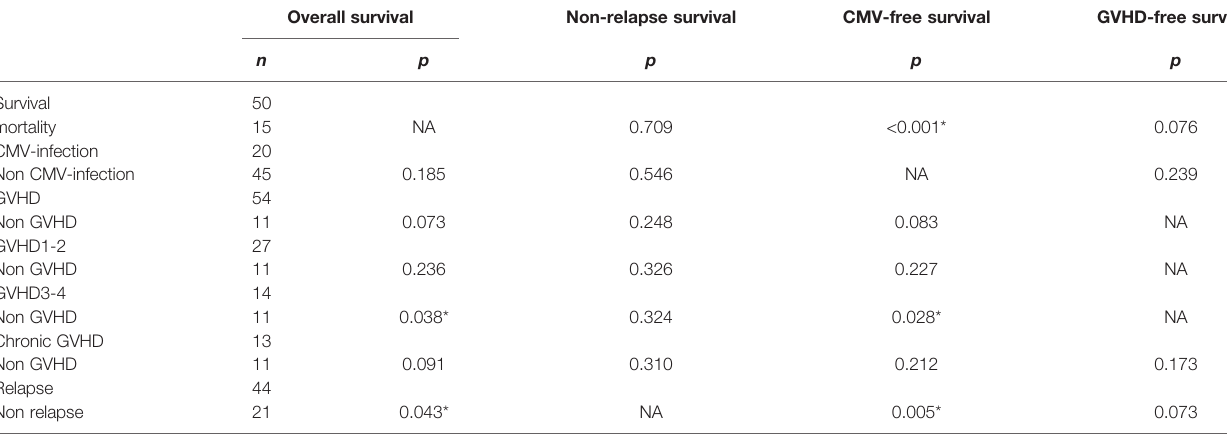
TABLE 8 | Analysis of the association between events and overall survival and event-free survival.